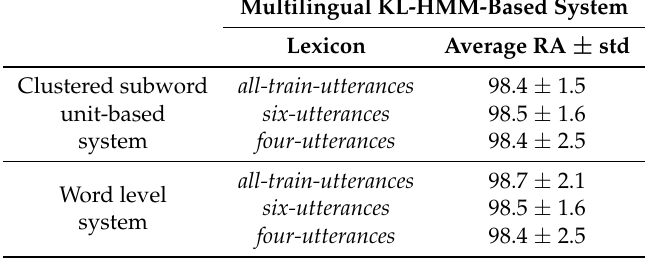
Table 6. Clustered subword unit-based and word level KL-HMM systems results on the PhoneBook database using multilingual phoneme classifier (without